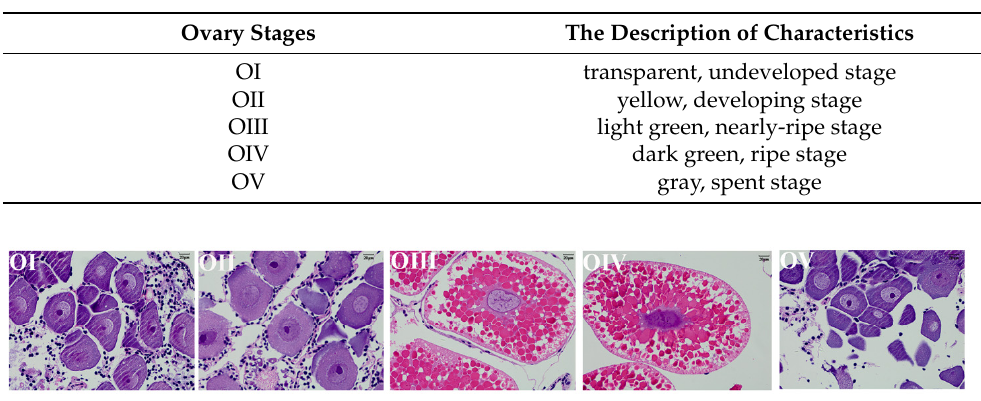
Table 1. Characteristics of 5 ovarian development stages.